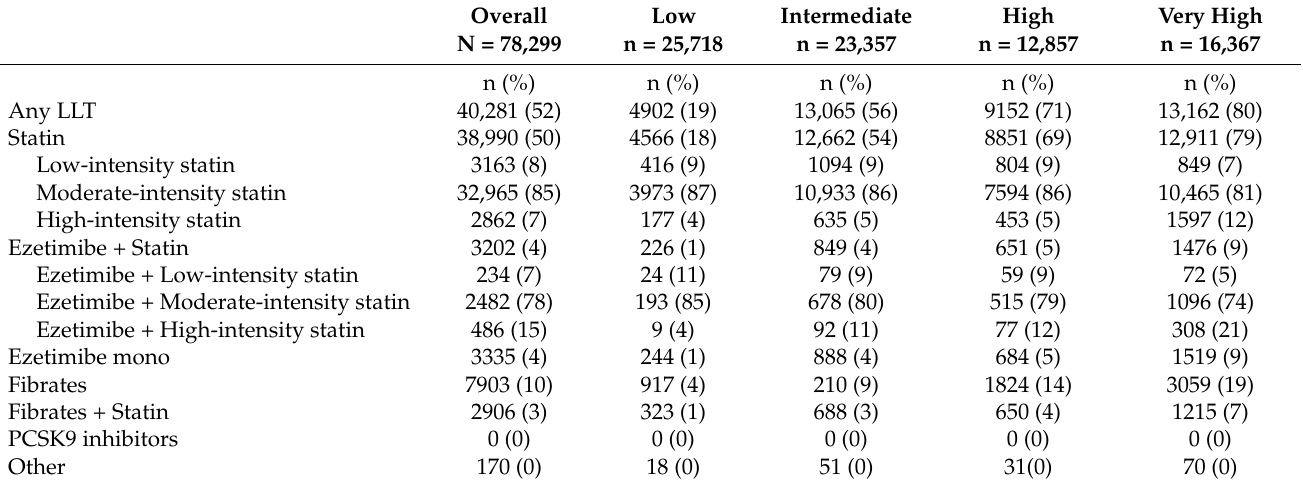
PCSK9: proprotein convertase subtilisin/kexin type 9.